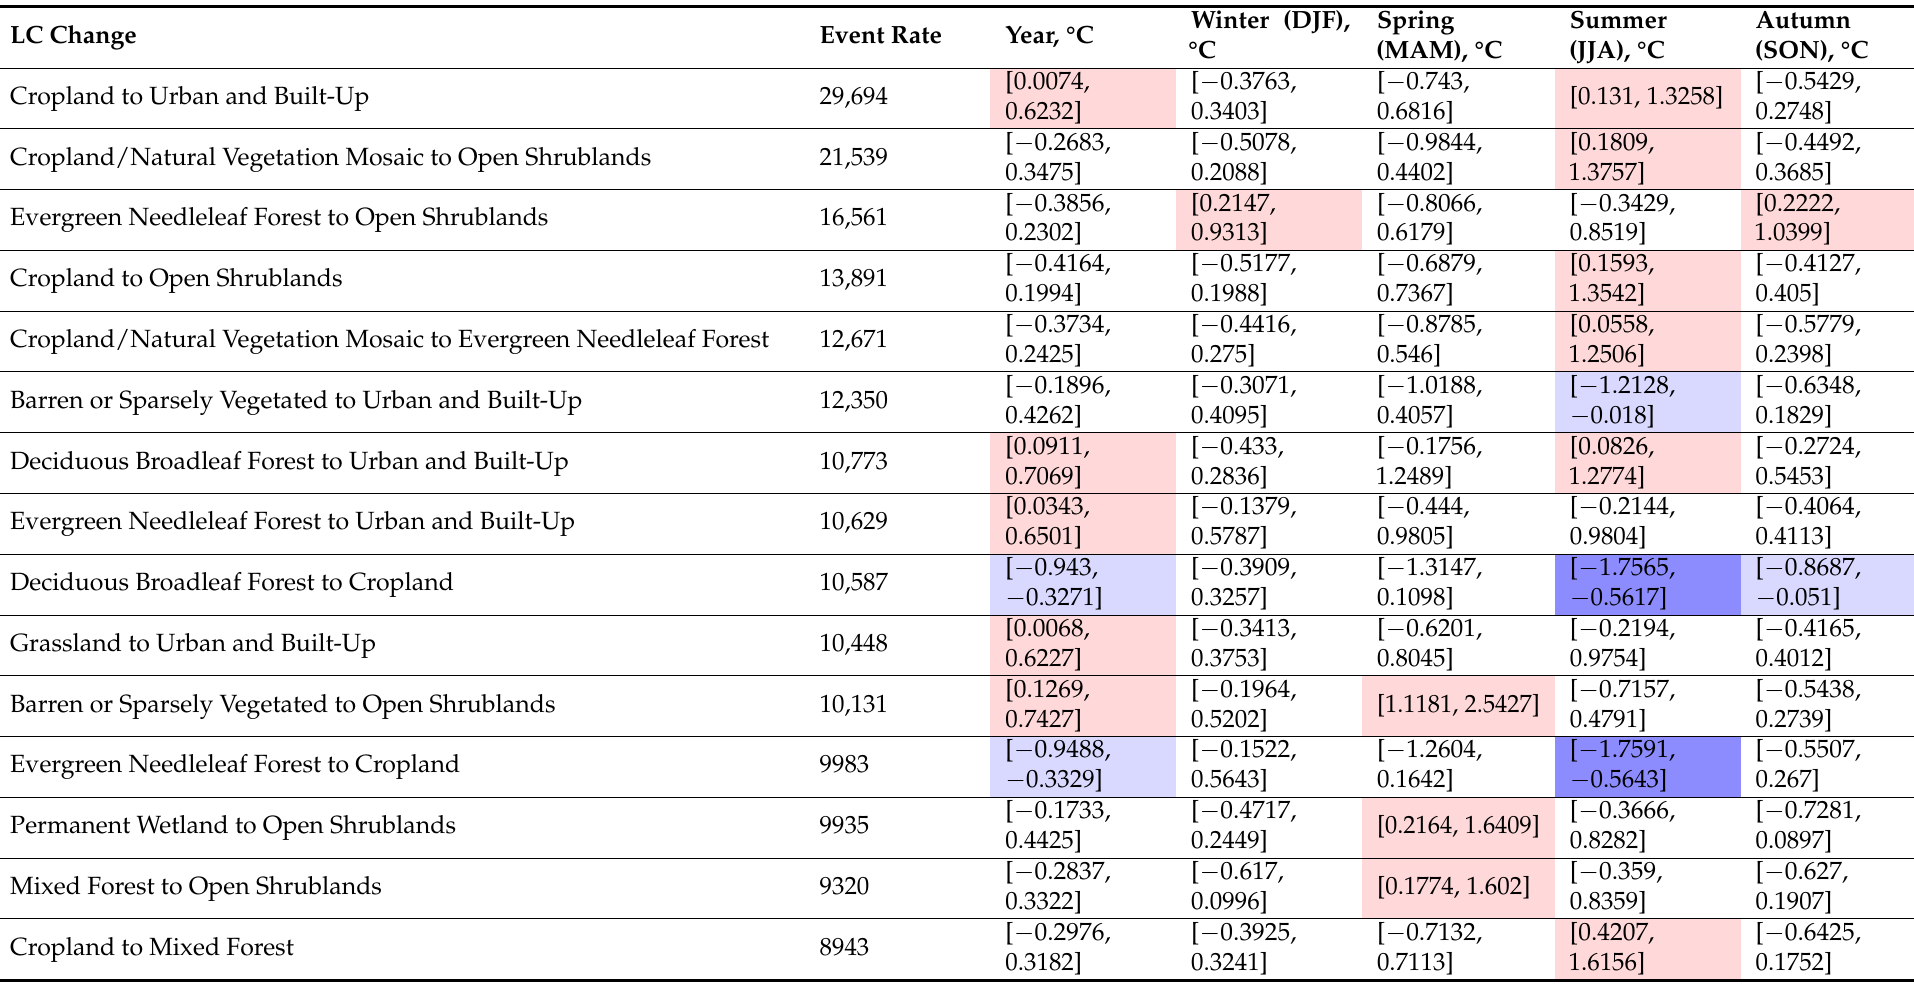
Table 3. Temperature changes in the whole of Europe depending on LC transformation. Blue and red cells represent LC changes resulting in statistically significant cooling and warming, respectively. Intense blue and red cells show cells where LC changes resulted in at least a 0.5 °C temperature change with 95%